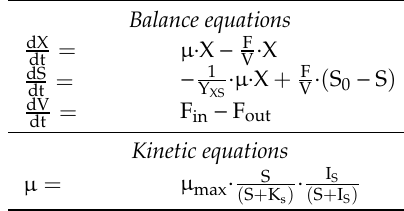
Table A11. Model equations for NMPC: Model B + (weighted sample points).